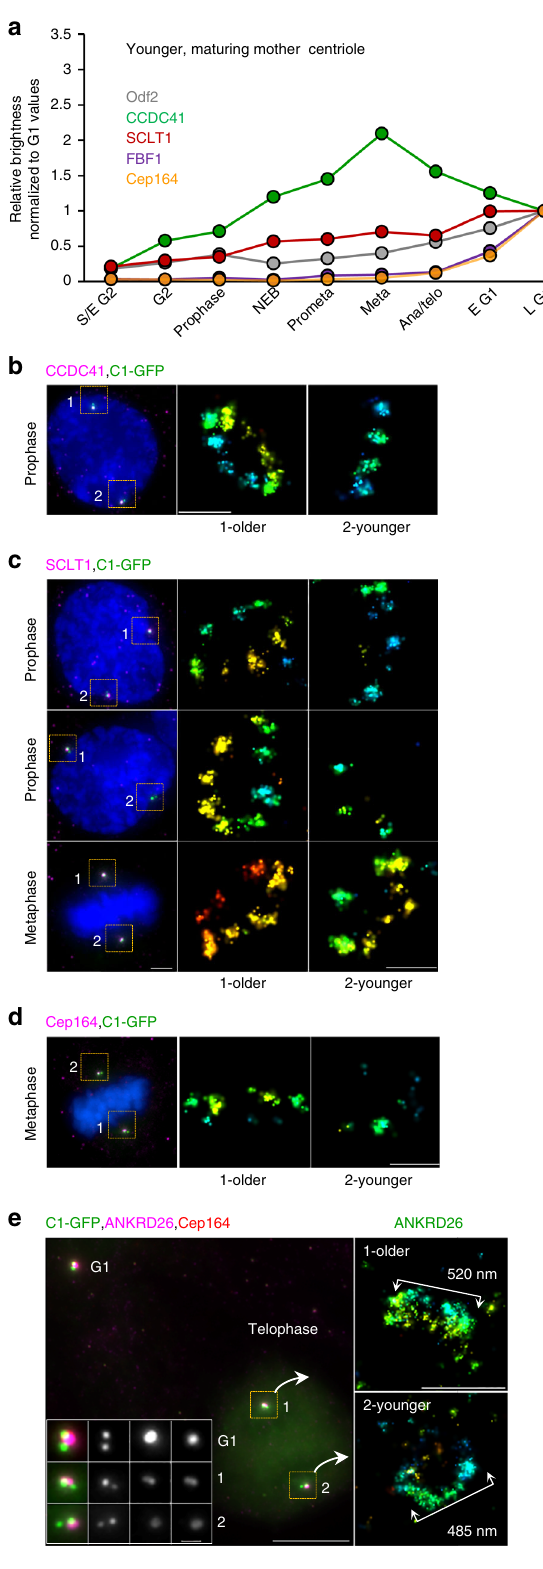
Fig. 5 Distal appendage assembly on younger mother centrioles. a Average levels of the DAPs and Odf2 associated with younger mother centrioles in RPE-1 during the cell cycle. n = 217 cells for Cep164, 135 for CCDC41, 155 for SCLT1, 176 for FBF1, 244 for Odf2. Box-and-whisker plots of the same dataset are presented in Supplementary Figure 5. Representative results from a single dataset; the quanti fi cation was performed several times with similar results (3x for Cep164 and FBF1, 2x for SCLT1, CCDC41 and Odf2). b In prophase, CCDC41 is localized in discrete foci on both the young and old mother centriole. c SCLT1 signal can be detected on maturing centriole from prophase to metaphase, but it is still not organized in nine densities as visible on older mother centrioles. d The levels of Cep164 are low in metaphase and the signal is not structured. Cep164 associated with older mother centriole is less abundant and unstructured than in interphase (compare with Fig. 2b and d). e In telophase, ANKRD26 is associated with the both mother centrioles but is organized in a smaller toroid than in interphase (compare with Fig. 1h). Scale bars: 1 μ m for wide- fi eld images; 200 nm for STORM images in ( b , c , d ) and 500 nm in ( e ). The source data underlying Figure 5a is provided as a Source Data fi